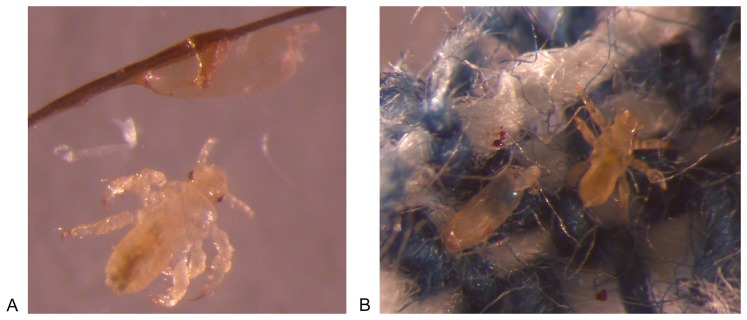
Picture of a head louse (A) and a body louse (B) and their respective nits.